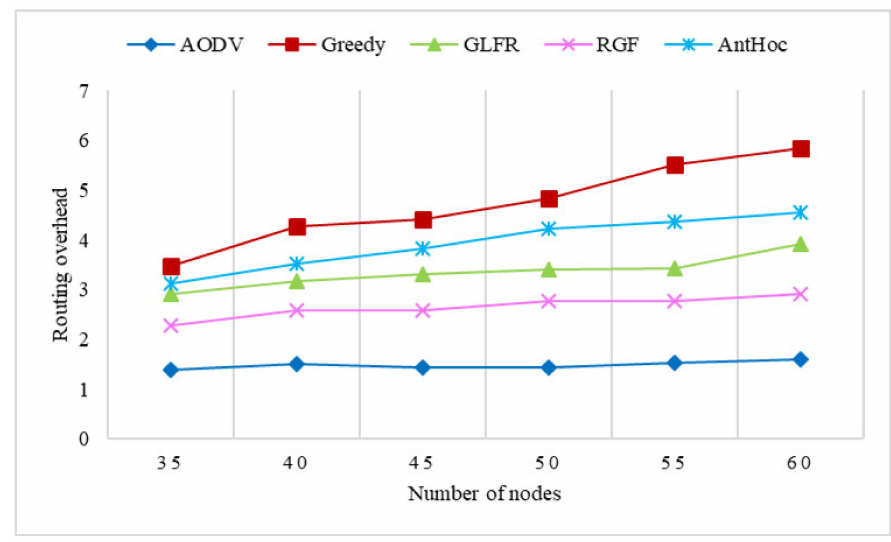
Figure 19. The effect of the number of nodes on routing